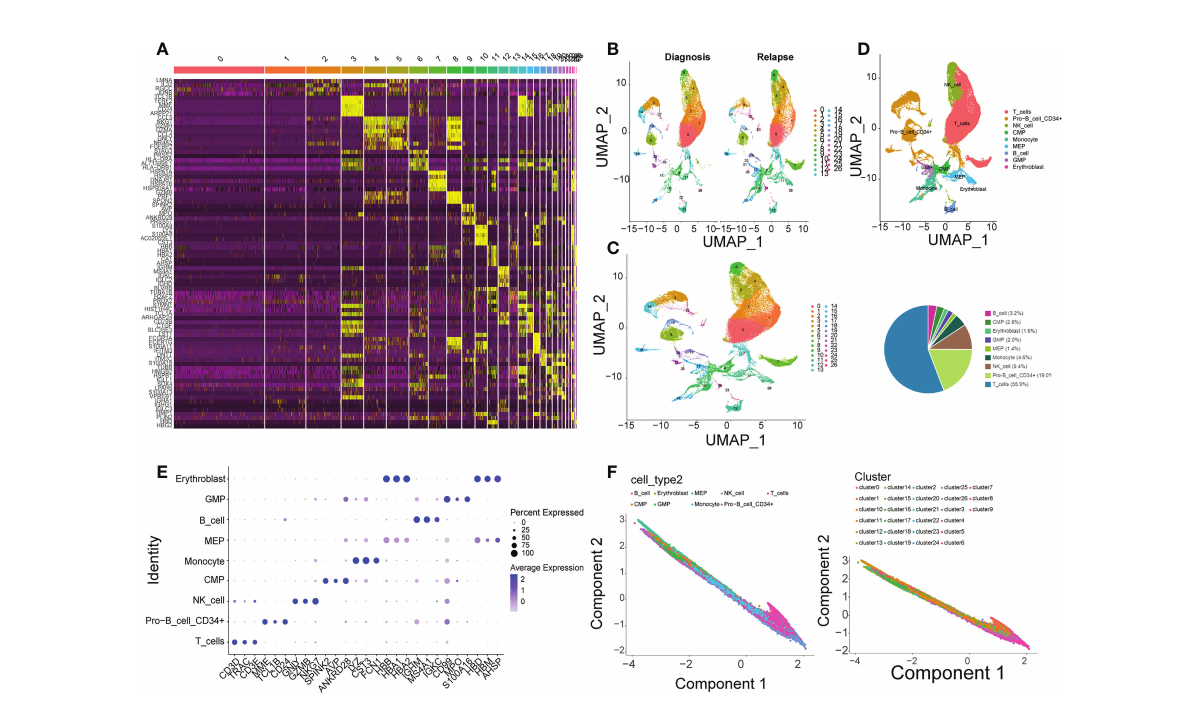
FIGURE 4 Single-cell analysis in GSE130116. (A) 26 clusters of core cells are identi fi ed in GSE130116 by UMAP2 algorithm. (B) The ratio of 26 clusters in initially diagnosed and relapse samples. (C) Heatmap of the expressions of top 5 gene markers in each cluster. (D) Functional annotations for 26 clusters by CellMarker. (E) Bubble plot of top 3 gene markers in each cell subset. (F) Visualization of inferred temporal trajectory of different cell